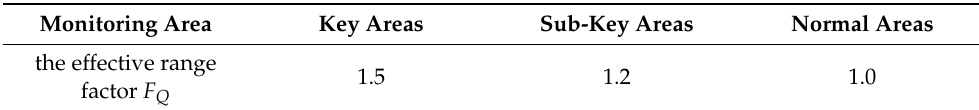
Table 1. The effective range factor of different monitoring areas. Key